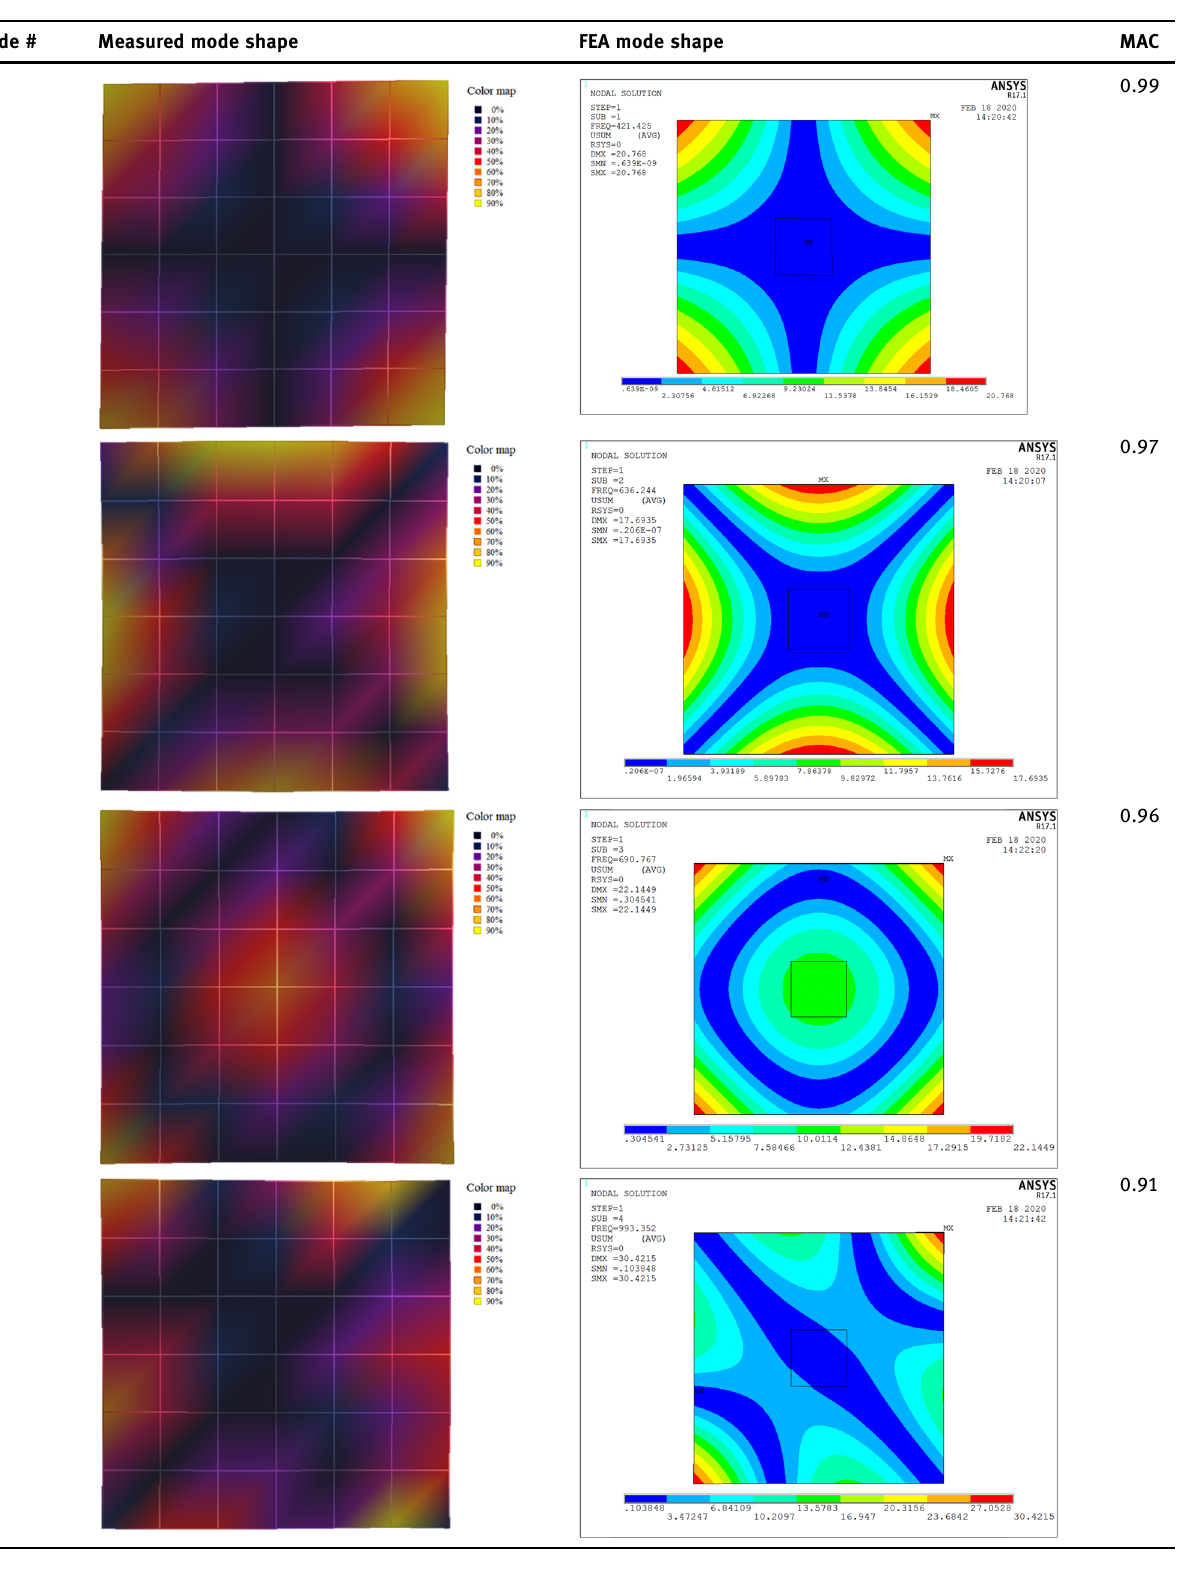
Table 6: Vibratory mode shapes correlation